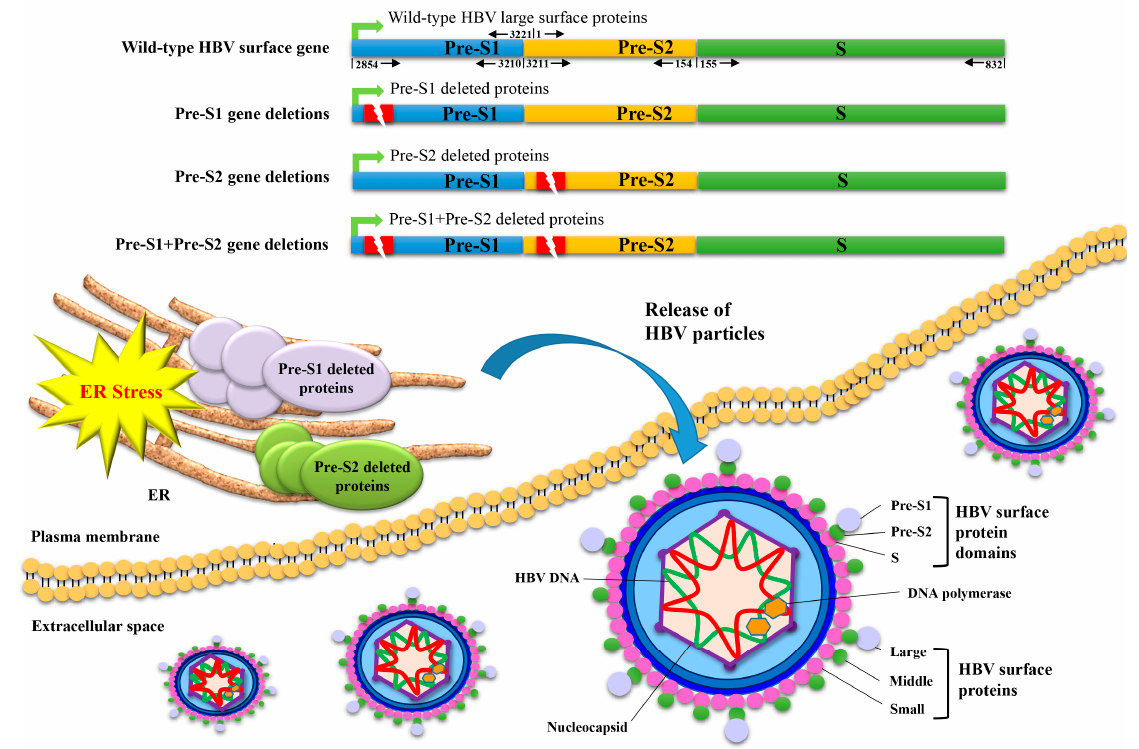
Figure 1. Schematic representation of HBV pre-S gene deletions and the expression and ER retention of pre-S deleted proteins. The HBV surface gene consists of three gene segments (pre-S1, pre-S2, and S) and expresses three different sizes of surface proteins (small, middle, and large) that are, respectively, composed of domains encoded from the S segment, the pre-S2 and S segments, and all three gene segments, collectively constituting the envelope proteins of viral particles. The